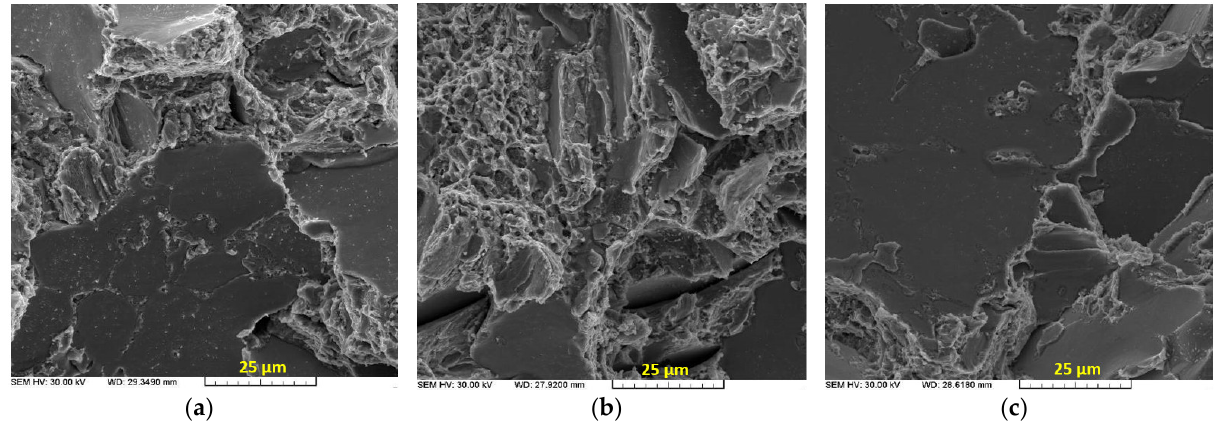
Figure 16. Fractography evaluation of ZnAl4Cu3 alloy with addition 3 wt.% Cd: ( a ) after first remelting, C1; ( b ) after third remelting, C3; and ( c ) after ninth remelting, C9.